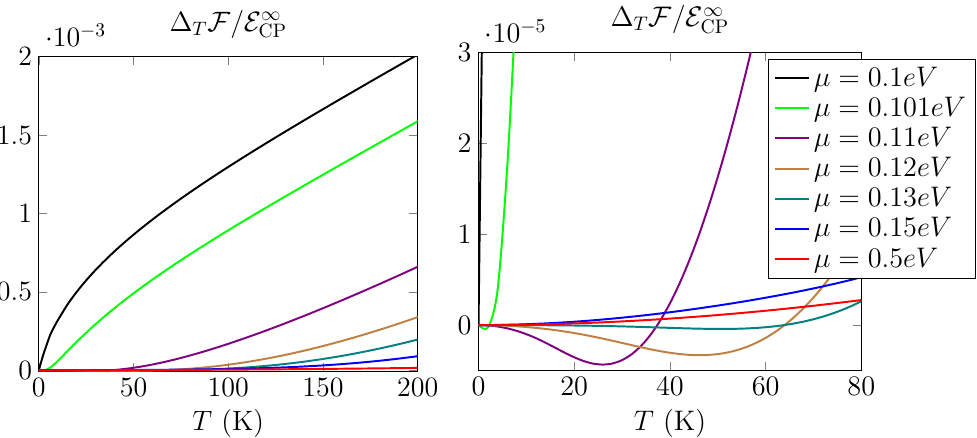
∞ . 0, the H tm → → m is shown in Figure 4. We observe that, for low ≥ G tm ( aT ) 2 , in agreement with (30) ∼